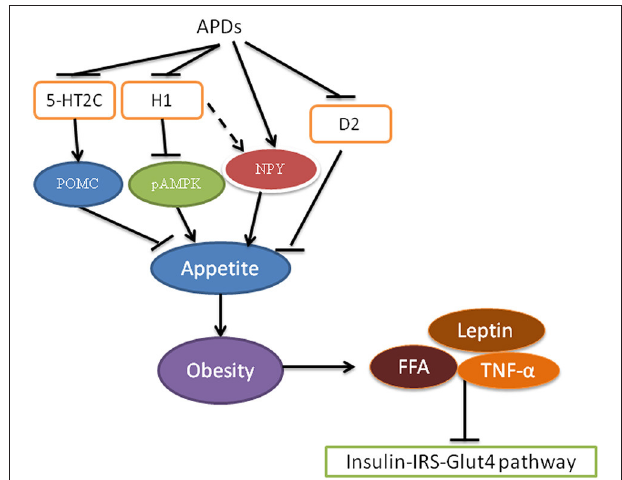
FIGURE 2 | Antipsychotics cause insulin resistance via obesity. Antipsychotics block receptors 5-HT2C, histamine H1 and D2 receptors resulting in a decrease in POMC and an increase in NPY production, leading to increased appetite. Increased food intake results in obesity, which is associated with insulin resistance via increased FFA, leptin and TNF- α . pAMPK, phosphor-AMP-activated protein kinase; APDs, antipsychotic drugs; FFA, free fatty acids; D2, dopamine D2 receptor; 5-HT2C, Serotonin 5-HT2C receptor; NPY, neuropeptide Y; POMC, proopiomelanocortin; TNF- α , tumor necrosis factor